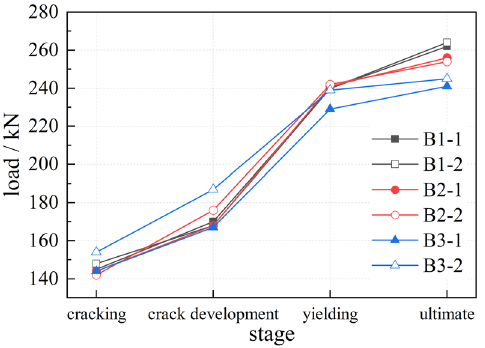
Figure 9. Control load of each stage of beams.